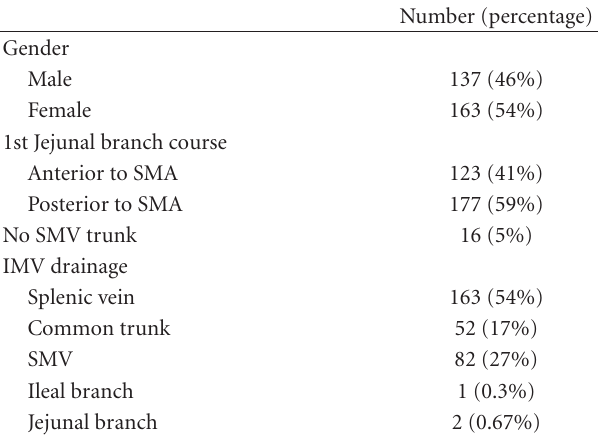
Table 1: Anatomic